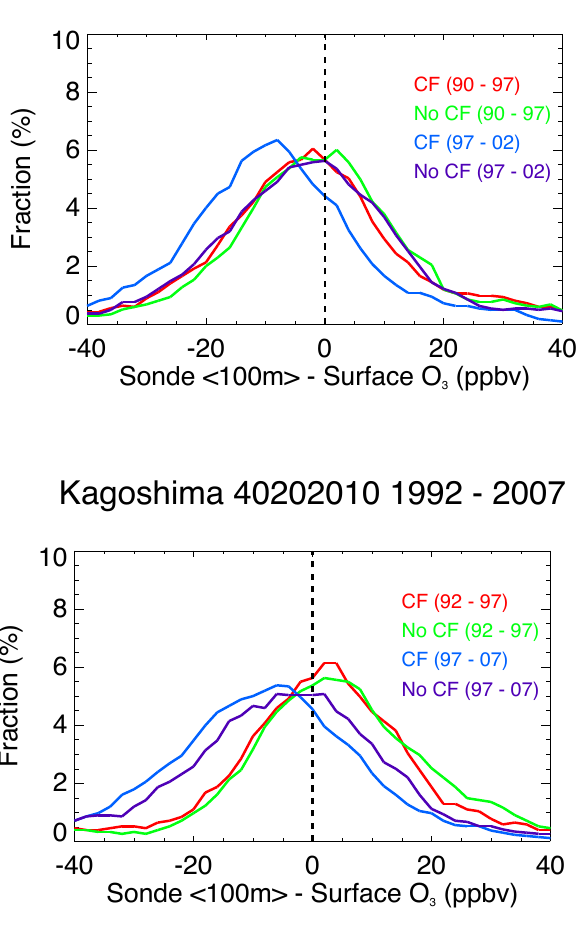
Fig. 7. As in Fig. 6, but with data separated into periods before and Figure 7. As in Figure 6, but with data separated into periods before and after 1997. See 1008 after 1997. See also Table 6 for a statistical analysis.